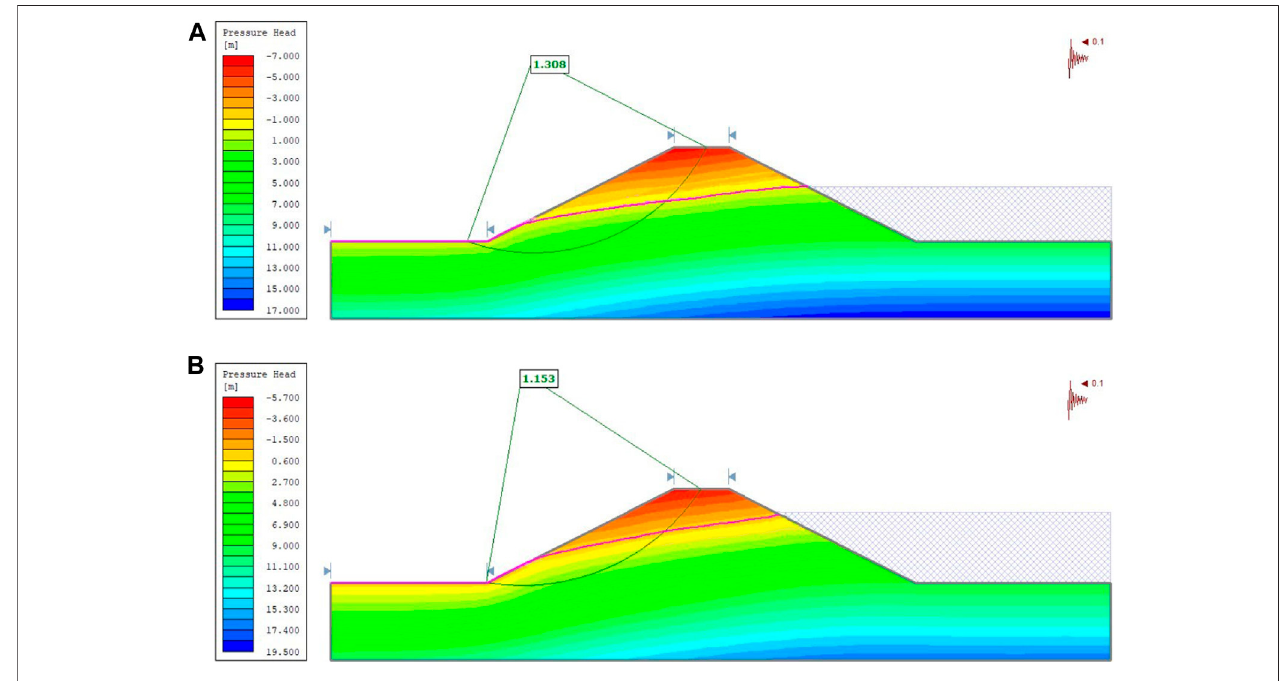
FIGURE 3 | The FS values of the embankment example at different times: (A) FS at the initial state; (B) FS at the 50 days.